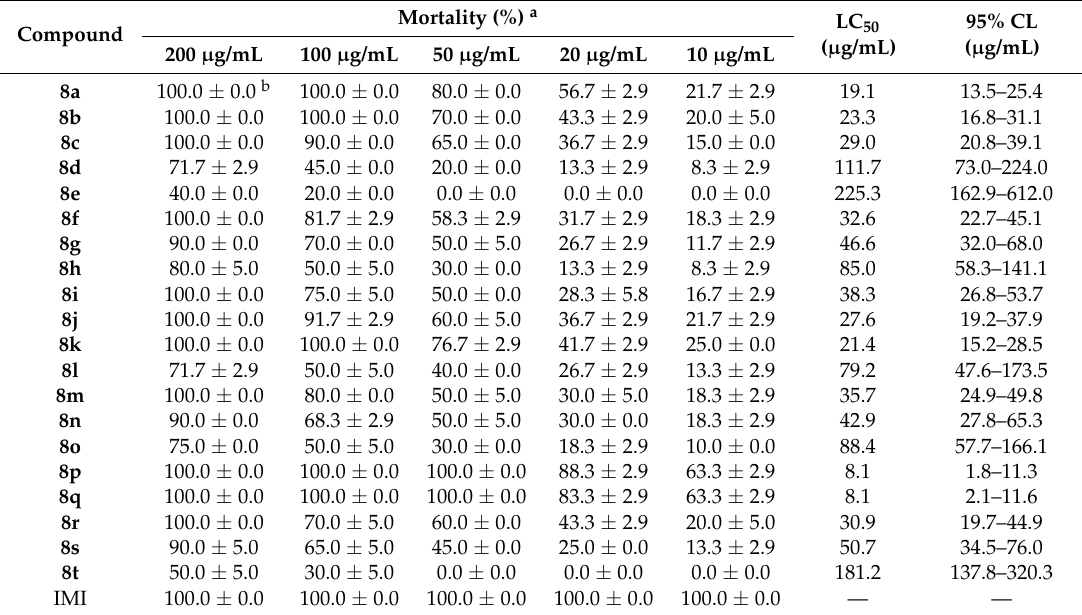
a Experimental size: 20 insects per group, three groups. b Each value represents the mean ± standard deviation of three replications; LC 50 = 50% lethal concentration; 95% CL = 95% confidence limit; “—” refers to “not